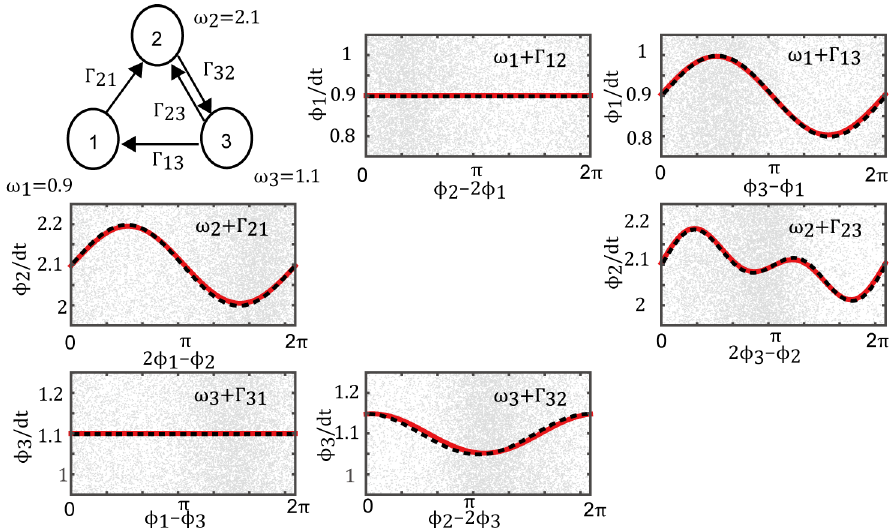
Fig 3. Estimated coupling function for numerical simulation data. Upper-left diagram shows the network structure. The estimated coupling functions (red lines) were nearly identical to the correct functions (dashed black line). The gray dots represent the phase time-series data. When the interaction did not exist, the estimated coupling function was identically zero. The proposed method estimated all coupling functions correctly for the simulation data.